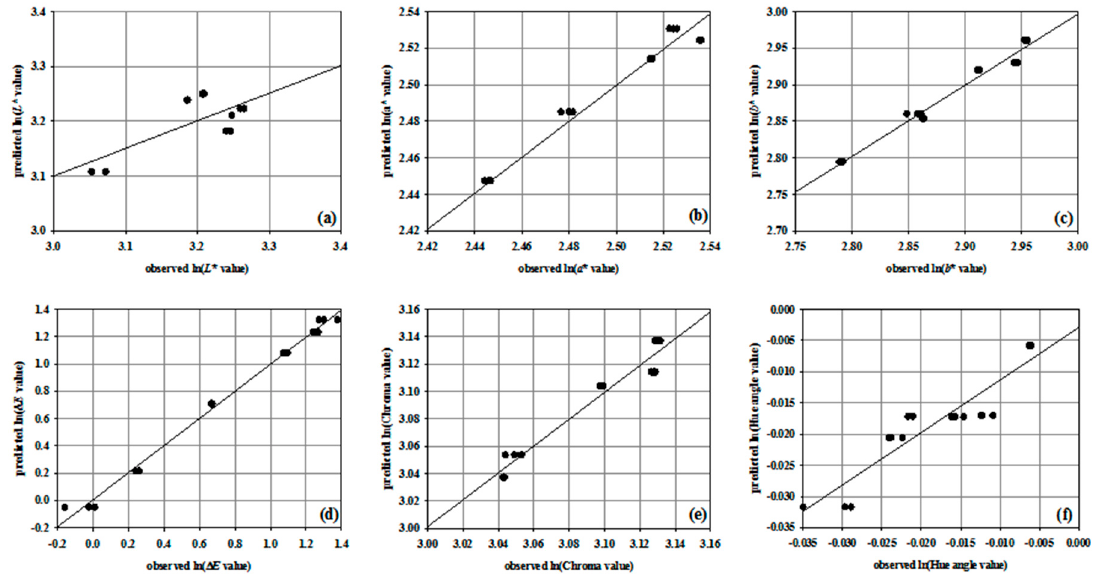
Figure 8. Linear regression models for description of colour components change during storage of V1KMK estimated using Statistica 10.0.: ( a ) L* , ( b ) a* , ( c ) b* , ( d ) Δ E , ( e ) Chroma, ( f ) Hue angle ( R 2 = 0.504, 0.984, 0.975, 0.993, 0.981, 0.842).